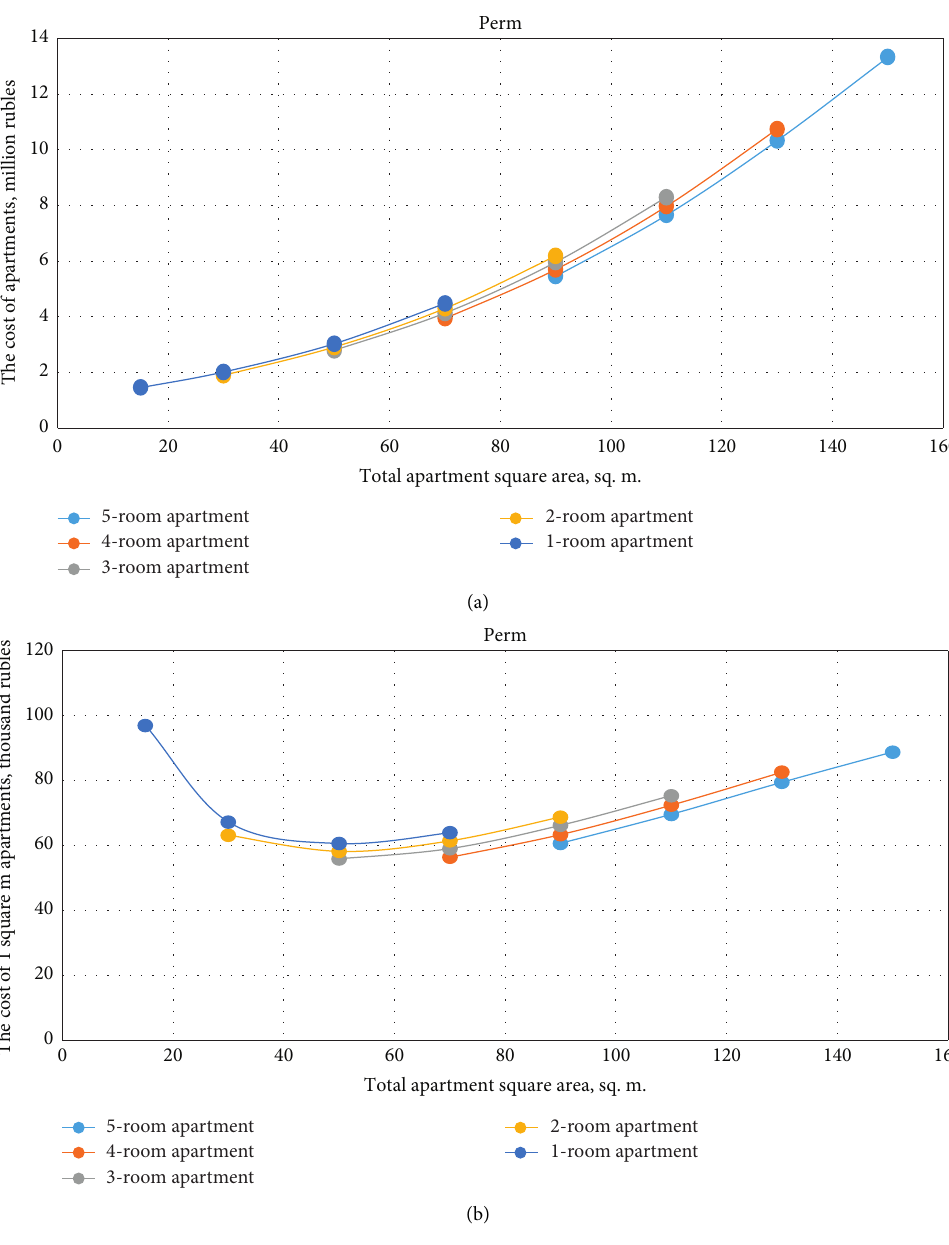
Figure 7: Influence of the square area of Perm apartments on their cost (a) and on the specific cost of one square meter